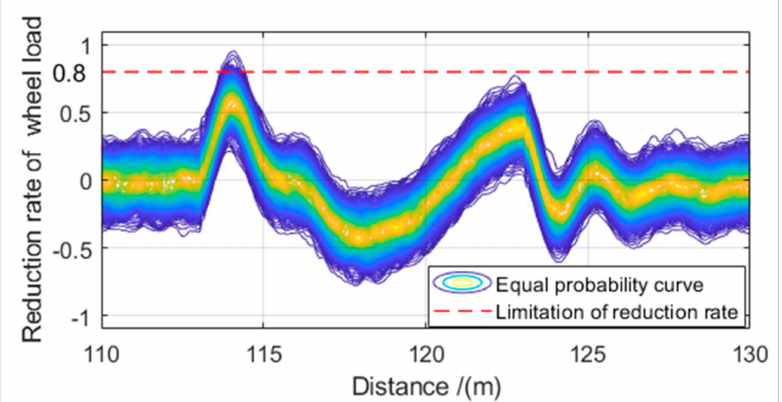
Figure 9. Equal probability curve of the reduction rate of wheel load at 12 mm